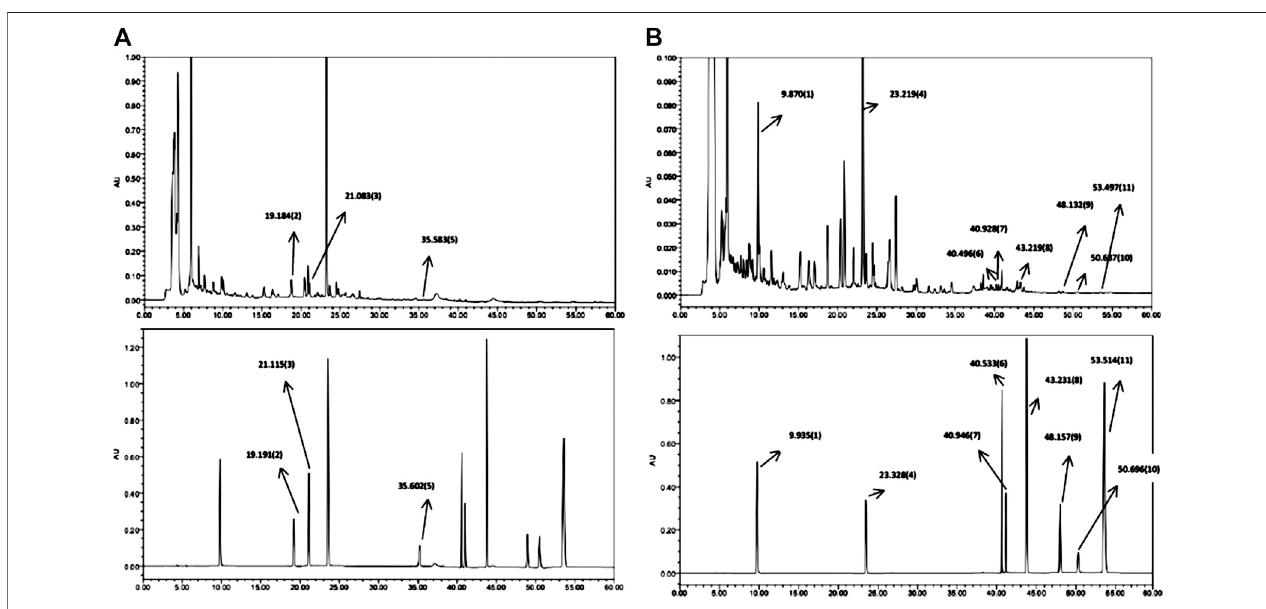
FIGURE 1 | HPLC chromatogram of LTF. (A) Chromatogram at λ max (cid:2) 210 nm. LTF is shown on top, while the reference standards are shown below. (B) Chromatogram at λ max (cid:2) 254 nm. LTF is shown on top, while the reference standards are shown below.